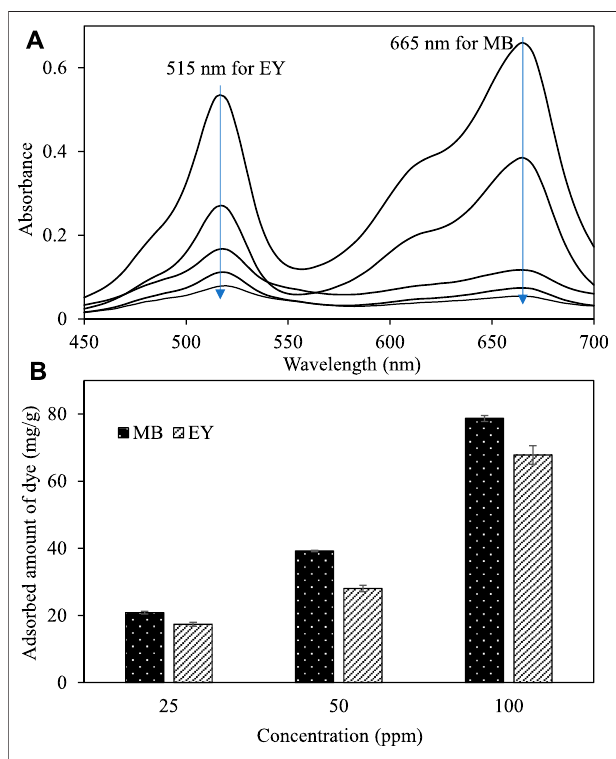
FIGURE 7 | (A) The UV-Vis spectra of simultaneous MB and EY adsorptionfrom50 ppm MB-EYmixturesolutionbyHCl-treatedp(APTMACl- co-AMPS)-3 hydrogels, and (B) the effect of dye mixture concentration on simultaneous adsorption of MB-EY from the mixture